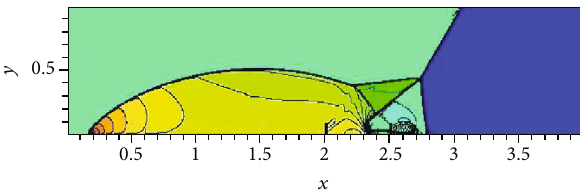
Figure 14: Density counters from 1.5 to 21.7 with 30 contours of double Mach re fl ection problem calculated by single WCNS. DOFs = 1200 × 300